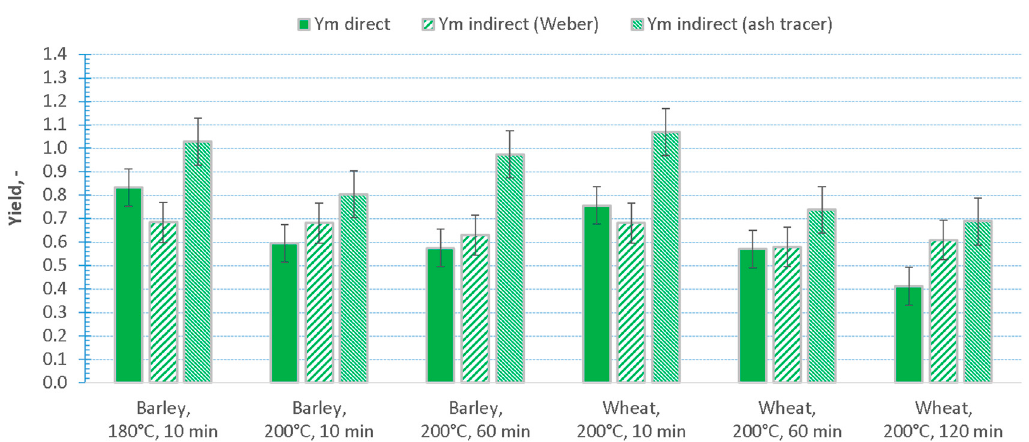
Figure 7. Comparison of mass yield, determined for hydrothermal carbonization experiments, by direct and indirect method.